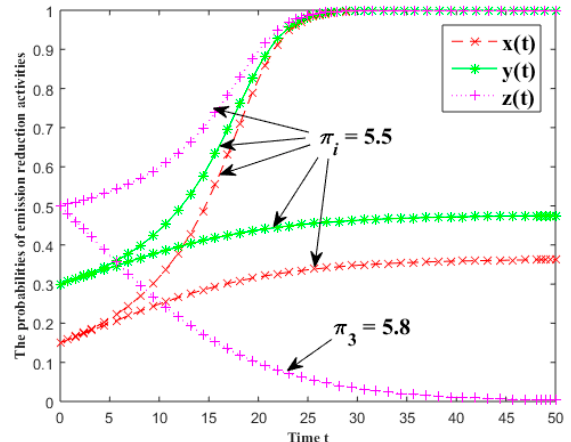
Figure 4. The effects of the free riding return of emission reduction on the probabilities of emission reduction activities.